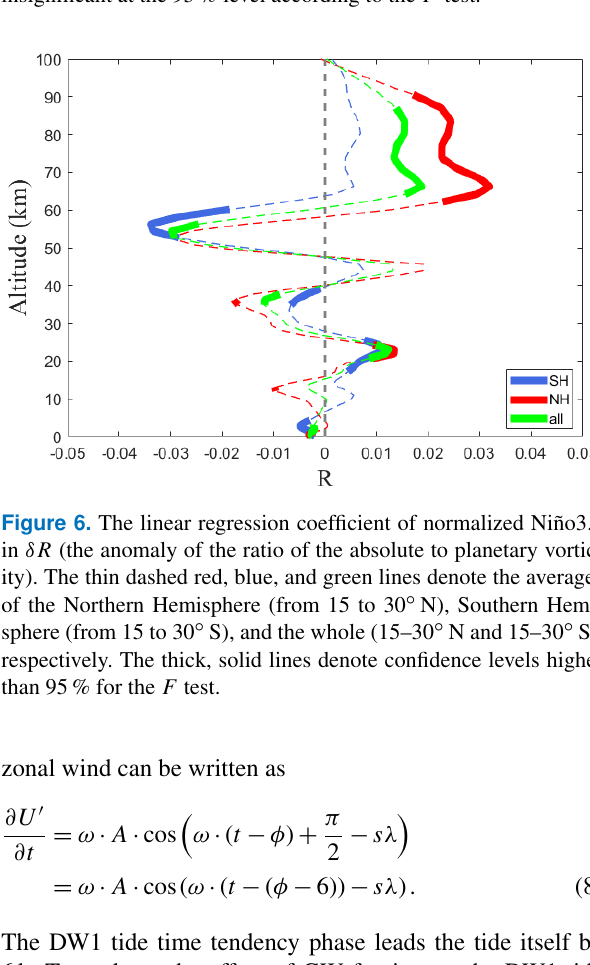
Figure 5. The linear regression coefficient of normalized Niño3.4 in SD-WACCM heating amplitude (mWm − 3 per index) during 1979–2013 winters (DJF). Solid lines and red shadings denote the positive responses, while dashed lines and blue shadings denote the negative responses; the grey regions indicate where the response is insignificant at the 95% level according to the F test.